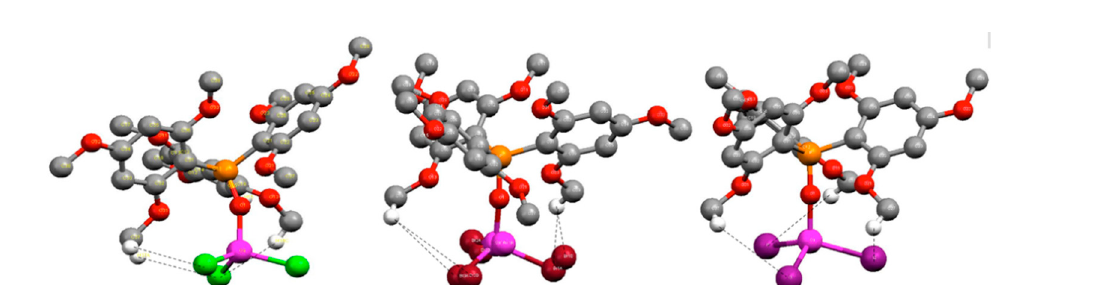
Table 2. Hydrogen bonding in 1, 2 and 3 (Å).